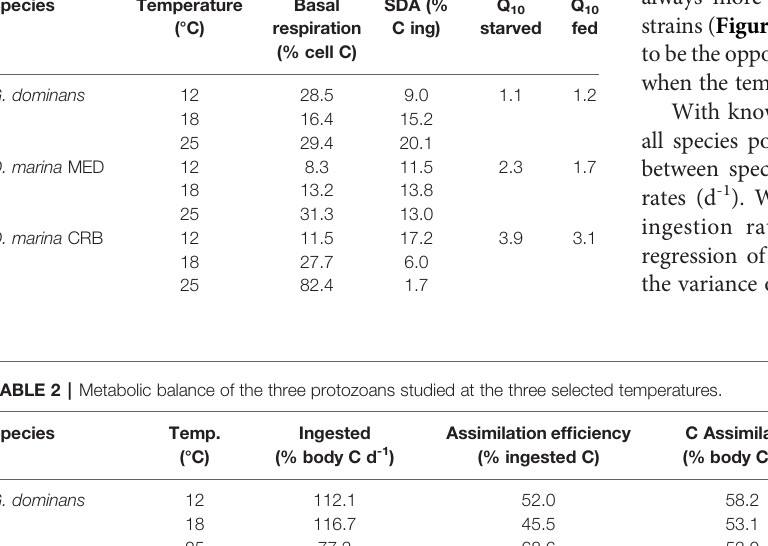
TABLE 1 | Basal respiration of starved organisms as % of the cell carbon, speci fi c dynamic action (SDA) as % of the carbon ingested, and Q 10 for starved and fed organisms at the three temperatures investigated.